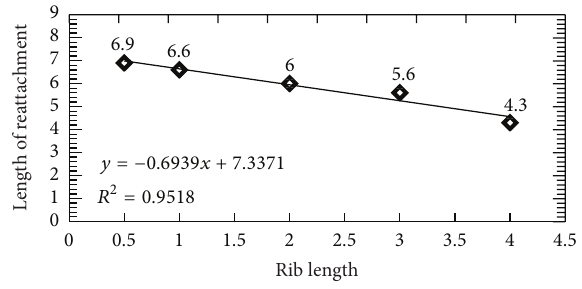
Figure 4: Length of reattachment under different rib